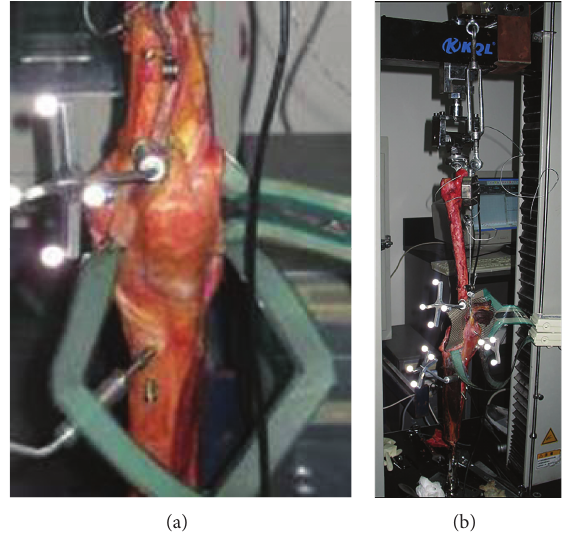
Figure 8: The device after installation.